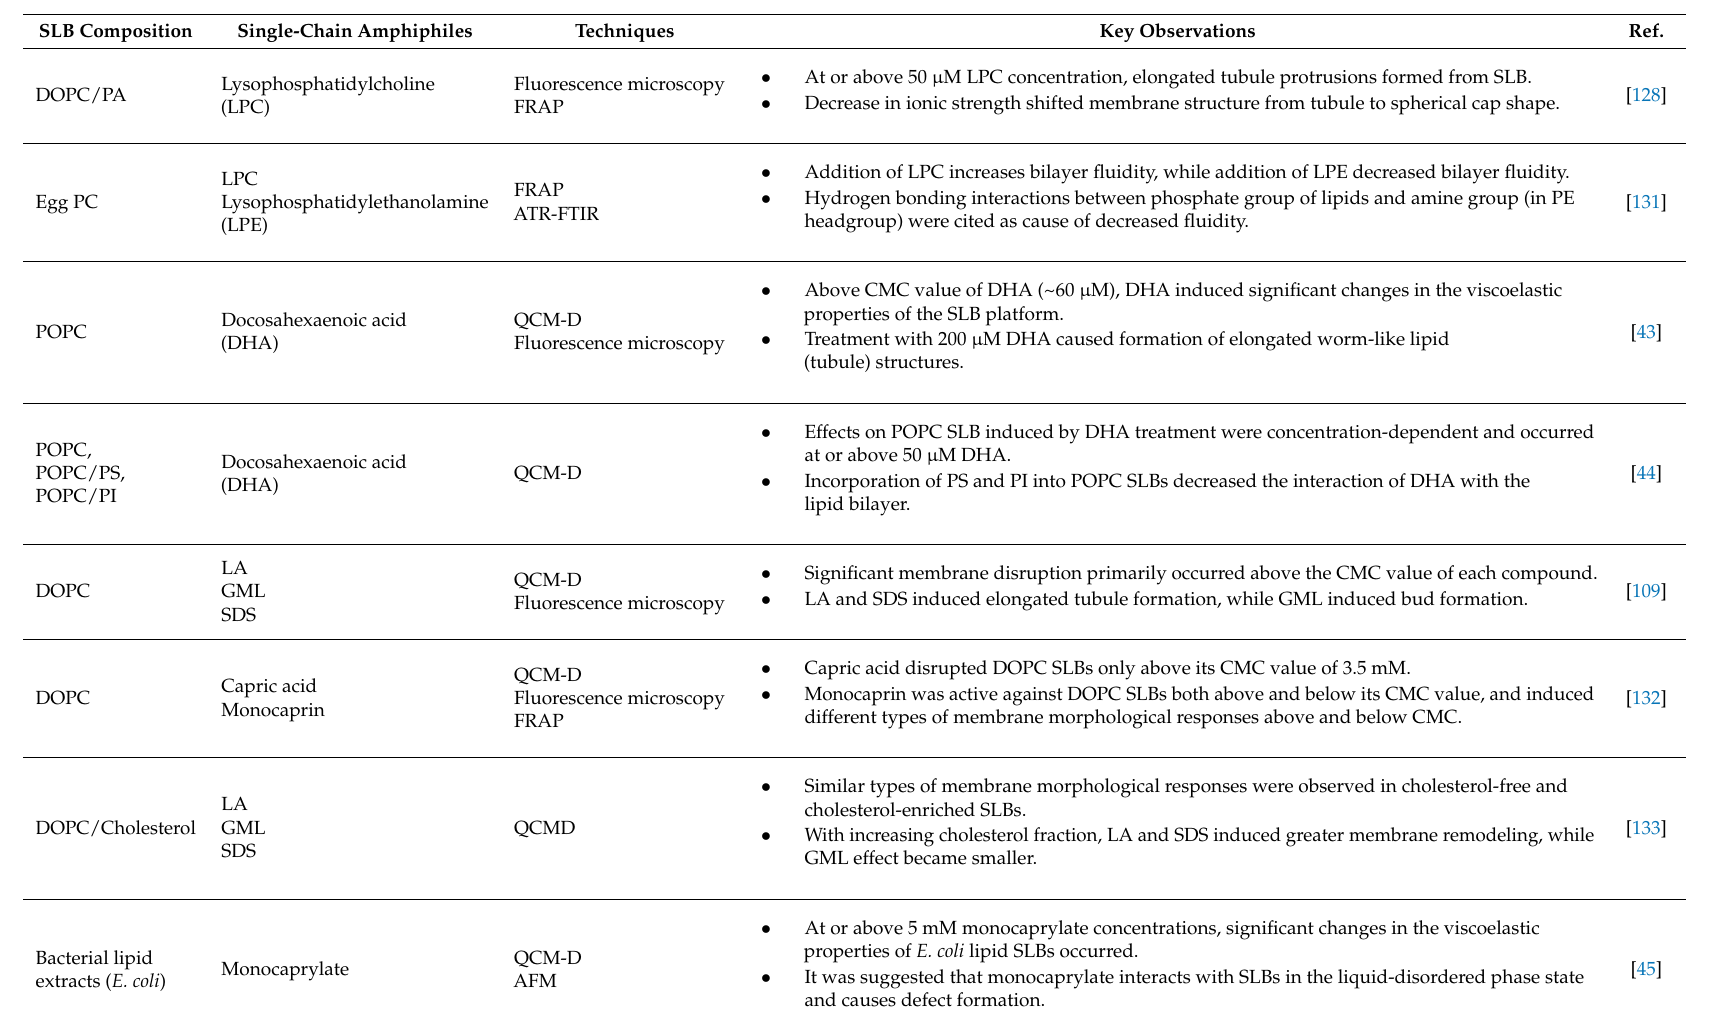
Table 7. Interactions of antimicrobial lipids and related single-chain lipid amphiphiles with SLB